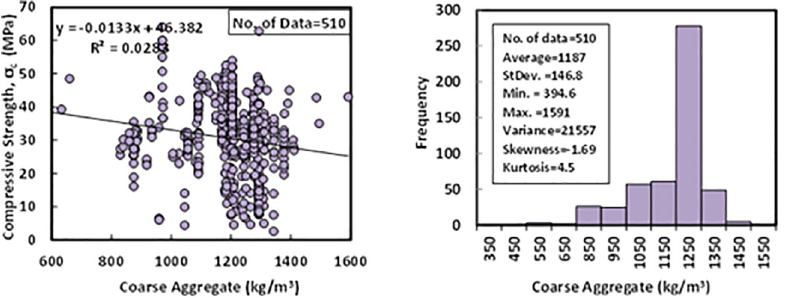
Fig 6. Variation between compressive strength and coarse aggregate content with a histogram of fly ash-based geopolymer concrete mixtures.